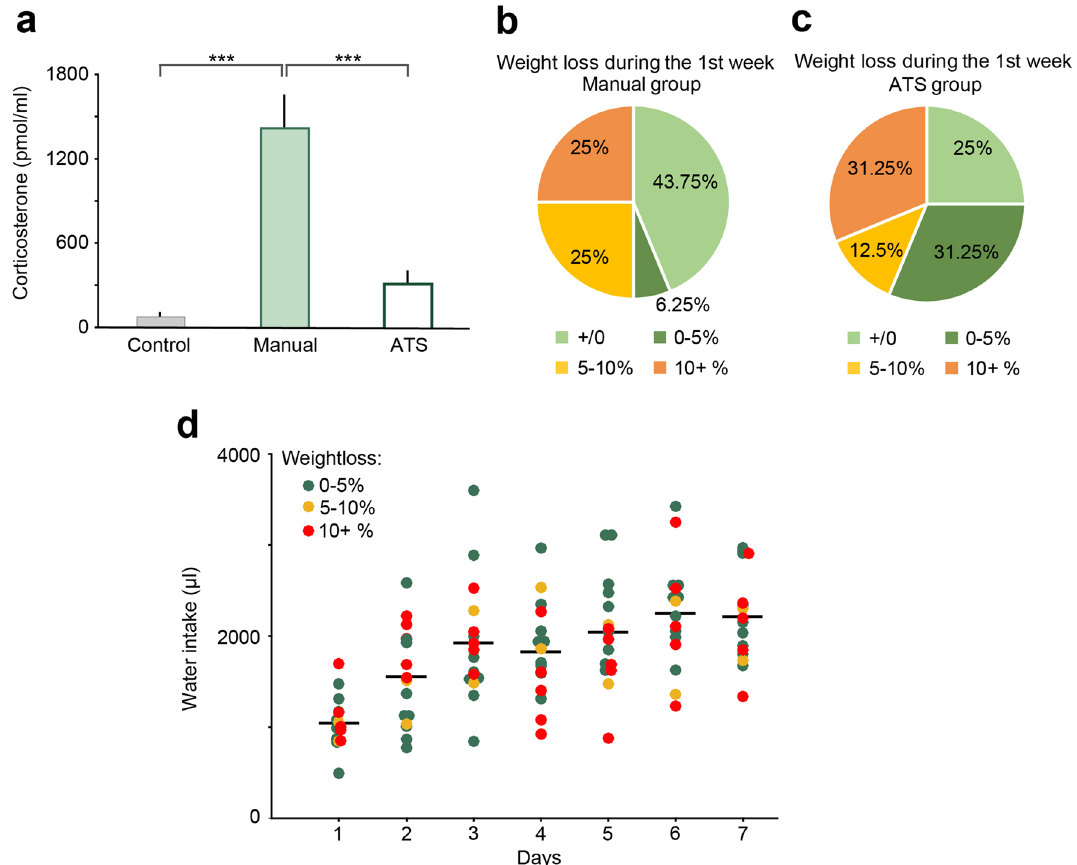
Figure 6. The effects of manual and ATS training protocols on stress hormone levels, bodyweight and water intake. ( a ) Blood corticosterone levels were higher in the manually trained mice when compared to the control or the ATS trained mice. There was no difference in blood corticosterone levels when comparing the control and the ATS trained mice. *** p < 0.001, one-way ANOVA; control, N = 6; manual, N = 6; ATS, N = 6. ( b – c ) Changes in body weight between training day 1 and 7 in the manually and ATS-trained mice. In the ATS group, more animals lost less than 5% of their bodyweight (including animals that gained weight) than in the manual group. ( d ) There was no correlation between bodyweight change and water intake in the ATS-trained mice. Dots represent the water intake of individual mice color-coded according to their bodyweight-change after one week of training. Lines represent average water intake. Manual, N = 16; ATS, N =